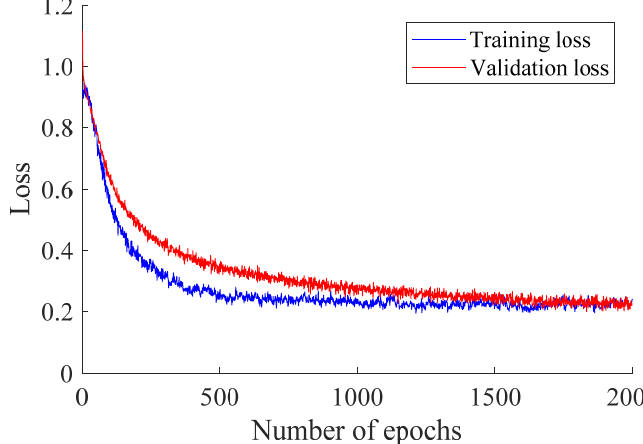
Figure 8. Training results of the proposed DNN model.